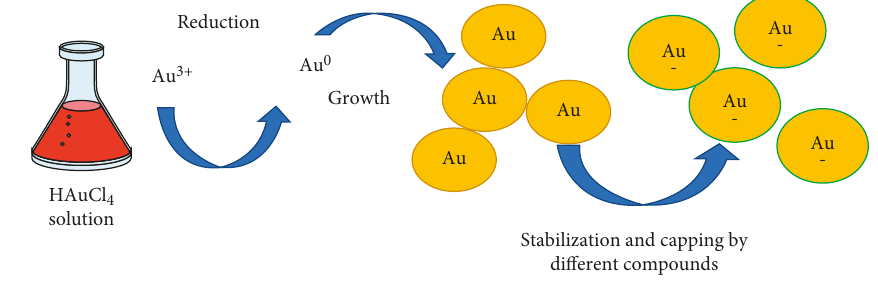
Figure 2: Mechanism of GNPs biosynthesis [22]. Table 1: Bacteria synthesize gold